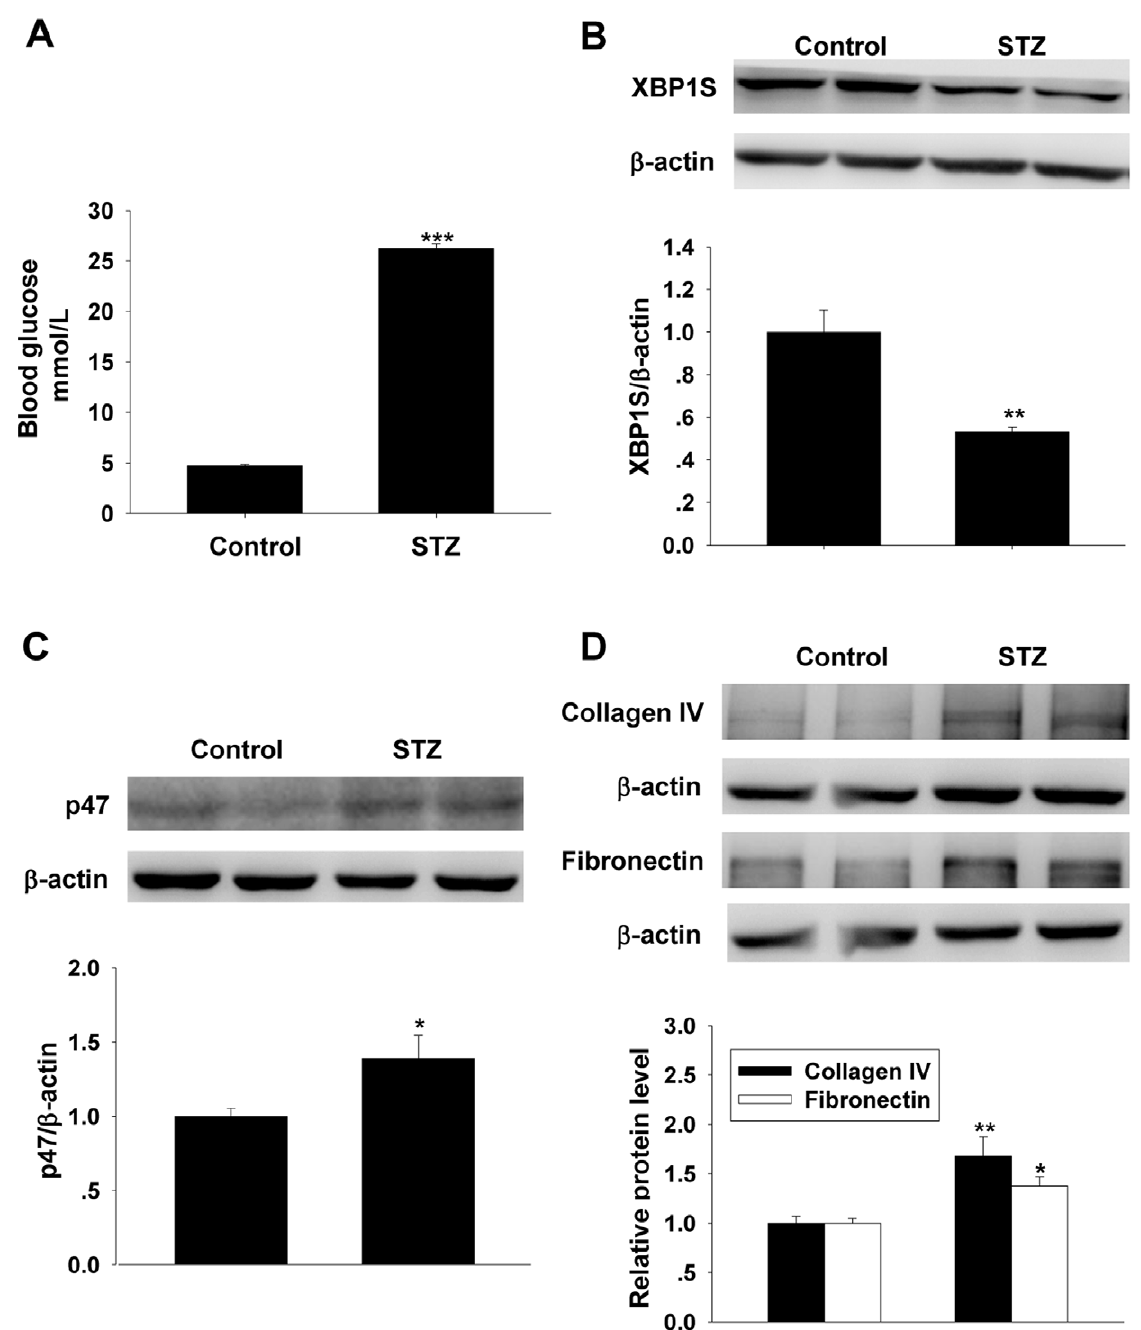
Figure 8. Changes in XBP1S and p47phox in diabetic renal cortex. A: plasma glucose level. B, C and D Western blot analysis on XBP1S, p47phox, collagen IV and fibronectin levels in renal cortex (mean 6 SEM, n=6). * p , 0.05 compared to non-diabetic rats; ** p , 0.01 compared to non- diabetic rats.